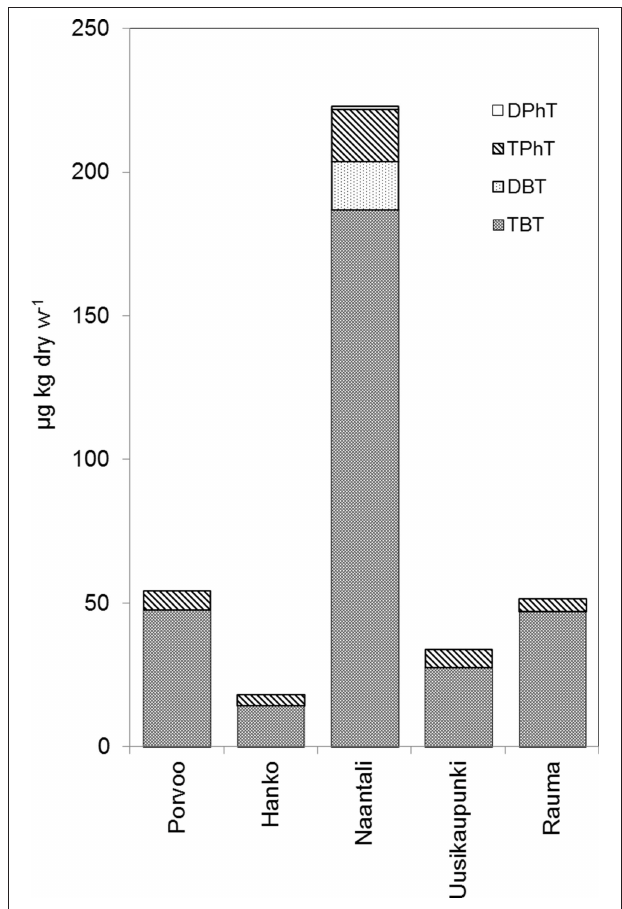
FIGURE 3 | Organotins ( µ g kg dry wt. − 1 ) in soft tissues of caged mussels from five study sites in 2017. MBT, MPhT, and DOT were not detected in any of the